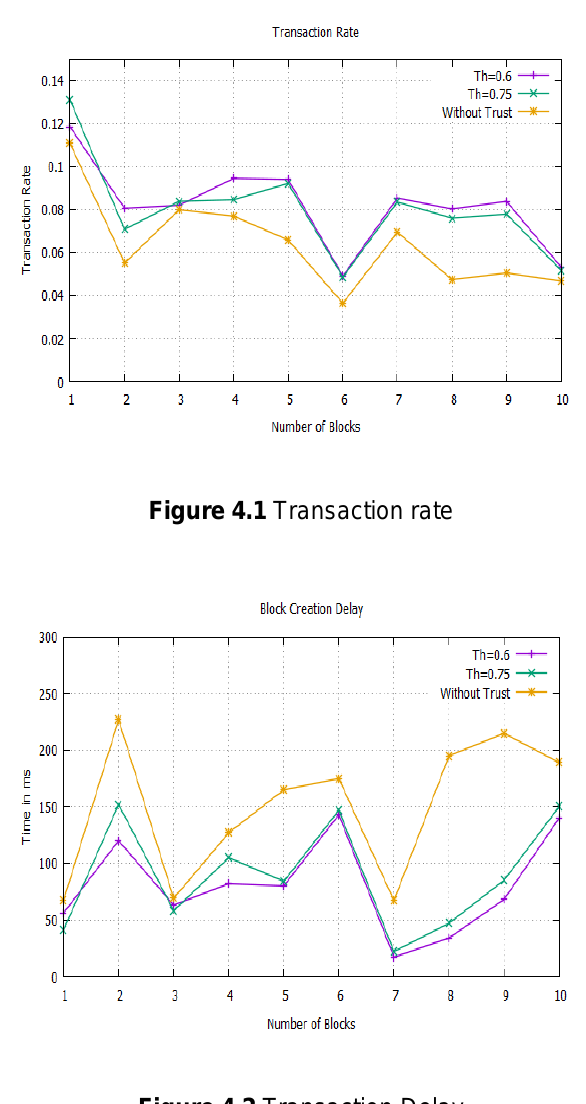
Figure 4.2 Transaction Delay